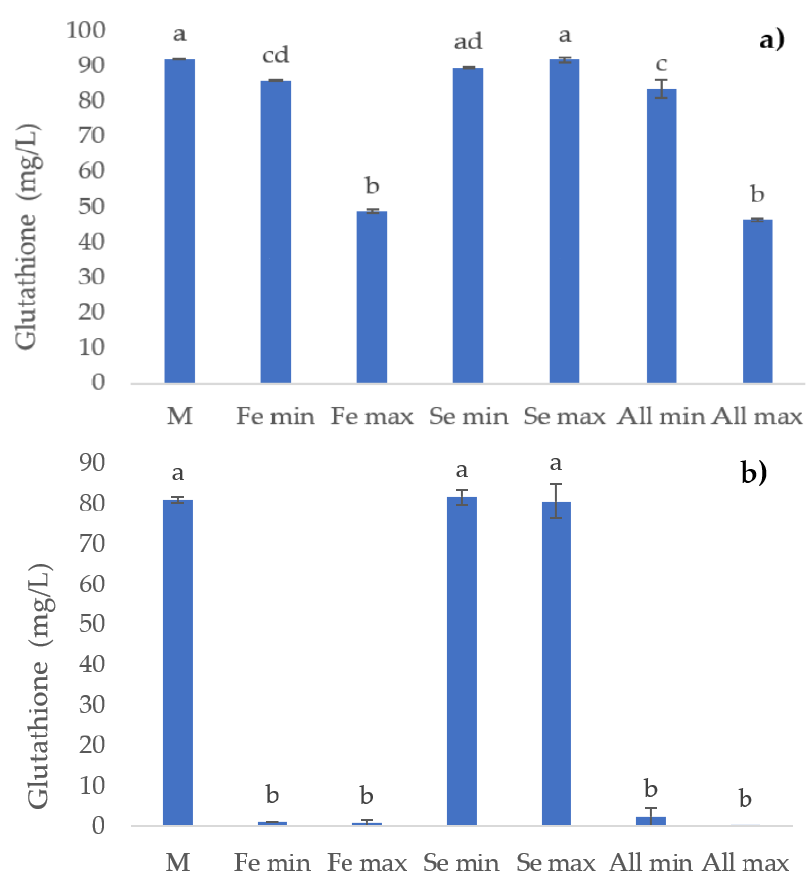
Figure 2. Total sulfhydryl groups (expressed as mg GSH/L) of samples after 12 days of heating at Figure 2: 35 ( a ) and 50 ◦ C ( b ). Different letters at each temperature studied indicate statistically significant differences ( p < 0.05). Sample codes are described in Table